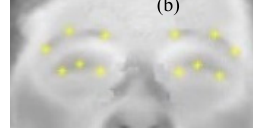
( b ) Figure 8. Recall graphs showing image registration accuracy of the coarse, coarse-Demons and coarse-spline models: ( a ) Markers in the face region as the control points based on the subjects in Table 1; ( b ) Landmarks around the eye region as the control points based on the subjects in Table 2. We also evaluated the registration accuracy for canthi localization using manually selected landmarks in the eye region as the control points (Figure 9). The point correspondence on contours around eye region like eyes corners, eye brows, and pupil as ground truth, were identifiable in both the visible and IR images. The registration accuracy was analyzed with both MSE (Table 2) and recall